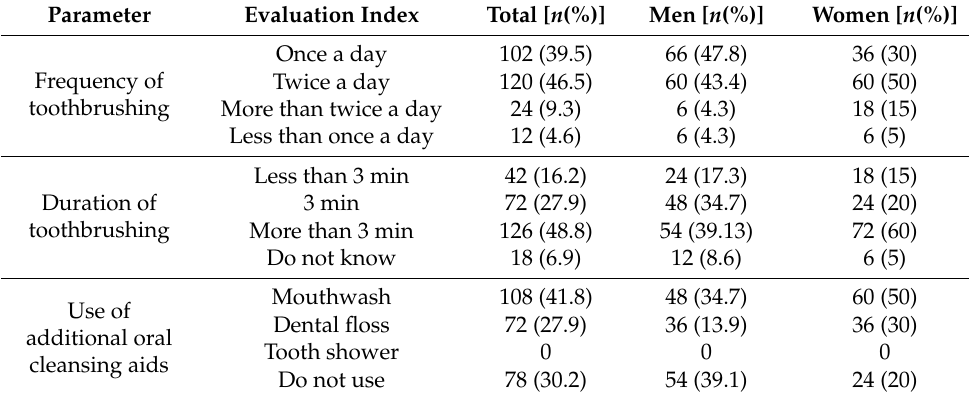
Table 4. Patients’ practices related to oral health.